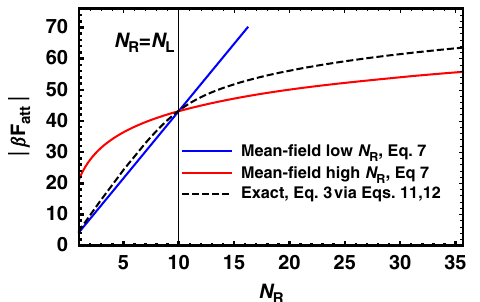
Fig. 3 Limiting scaling behaviour of the ligand – receptor attractive contribution. Low ( N R ≪ N L , blue) and high ( N R ≫ N L , red) limiting behaviours of the binding free-energy β F att in the radial binding scenario as calculated via Eq. (3) (using an almost exact approximation via Eqs. (13), (14), see Methods). The black vertical line represents the boundary between the high and low receptor regime, where N R = N L . Crucially, in the high-receptor regime the free-energy only grows logarithmically with N R , see Eq. (7), unlike the repulsive factor that grows linearly, Eq. (4). For this reason, above a certain receptor number the total free-energy of interaction becomes positive (with respect to nanoparticles in the bulk) and binding is